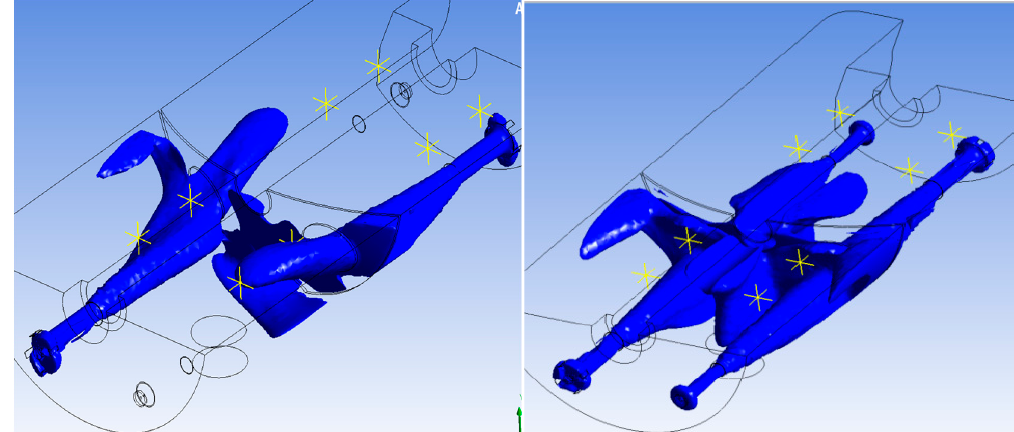
Figure 8. Iso-velocity diagram at 0.2 m/s with ( left ) two and ( right ) four active nozzles in a tank with 1000 L. Scale 1:60.